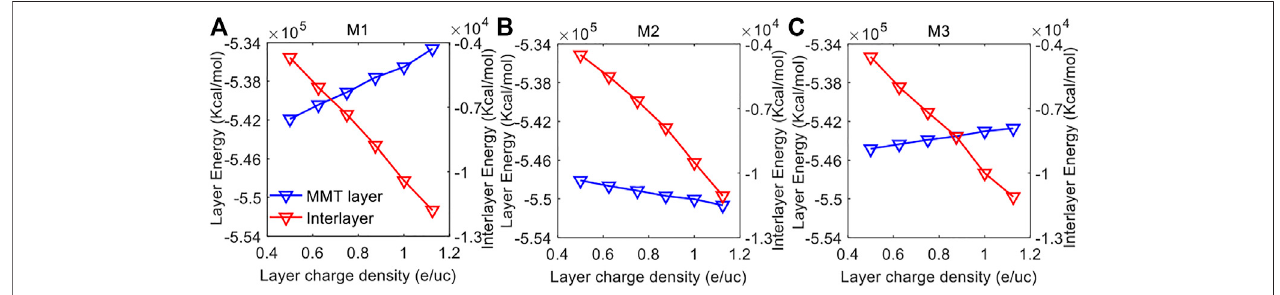
FIGURE 6 | The interaction energy of each MMT layer and interlayer as a function of layer charge density for the (A) M1 Model, (B) M2 Model and (C) M3 Model.